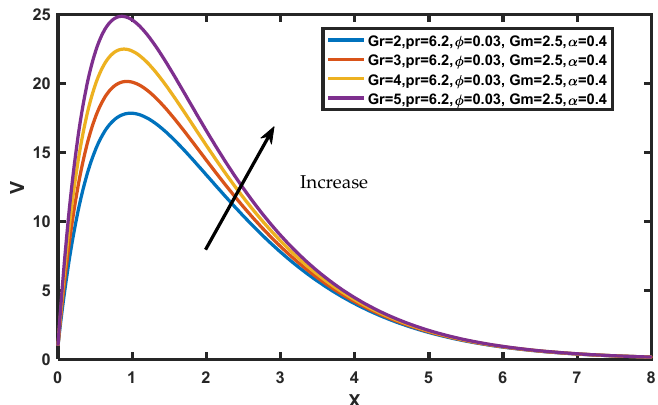
Figure 3. Variation of Gr in v . Figure 4. Variation of Gm on v .